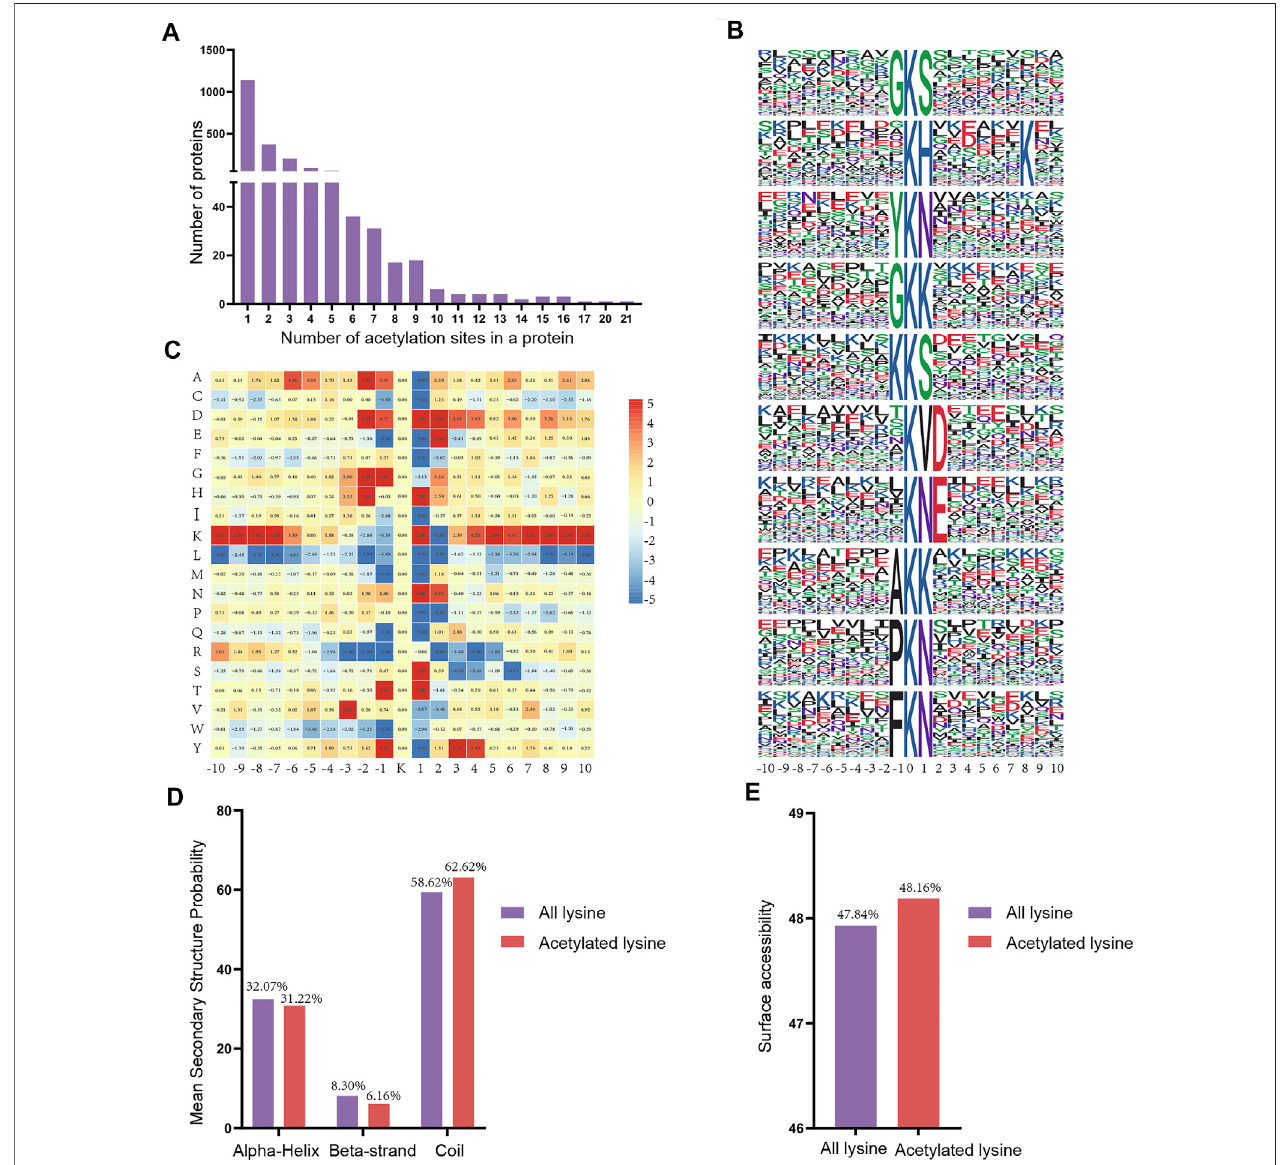
FIGURE 6 | Properties of the acetylated peptides. (A) Distribution of acetylated proteins based on the numbers of acetylation sites. (B) Sequence probabilities of signi fi cantly enriched acetylation site motifs with 10 amino acids around the lysine acetylation site. (C) Heat map showing acetylation motif enrichment. (D) Secondary structure distribution of lysine acetylation sites. (E) Surface predictive accessibility of acetylation sites.